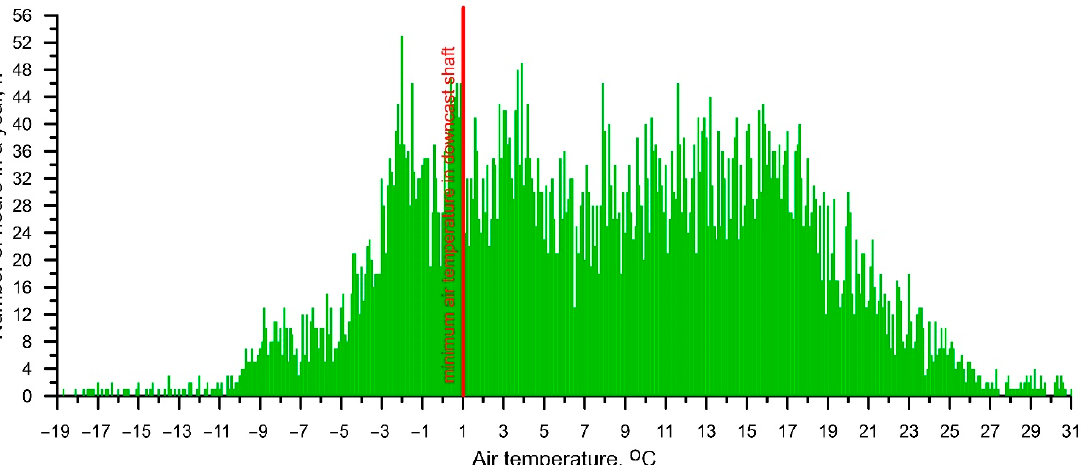
Figure 10. Frequently of occurrence temperatures during typical meteorological year for Katowice.